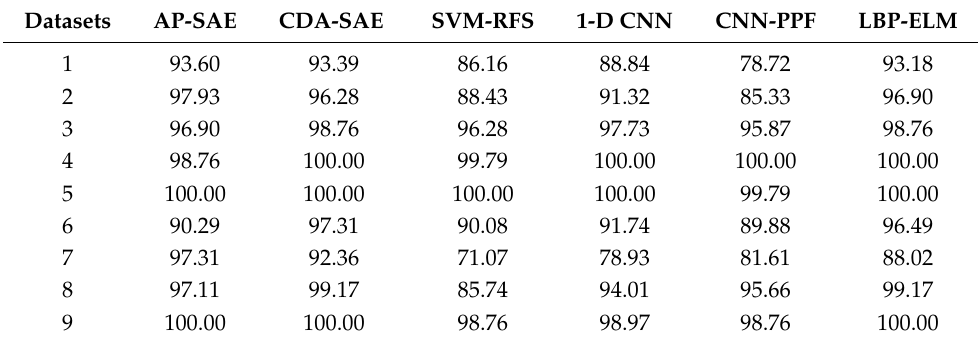
Table 11. Different methods of various types of accuracy comparison results for the Indian Pines dataset.